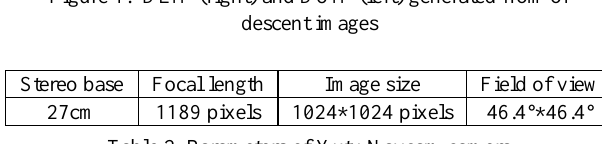
Figure 1. DEM (right) and DOM (left) generated from of